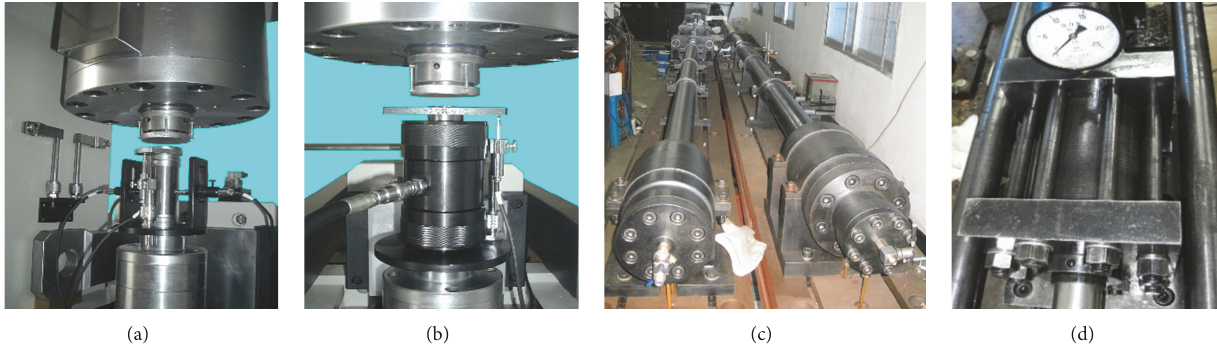
Figure 5: Various parts of RMT-150C and SHPB testing system: (a) uniaxial static system; (b) triaxial static system; (c) SHPB testing system; and (d) triaxial static-dynamic